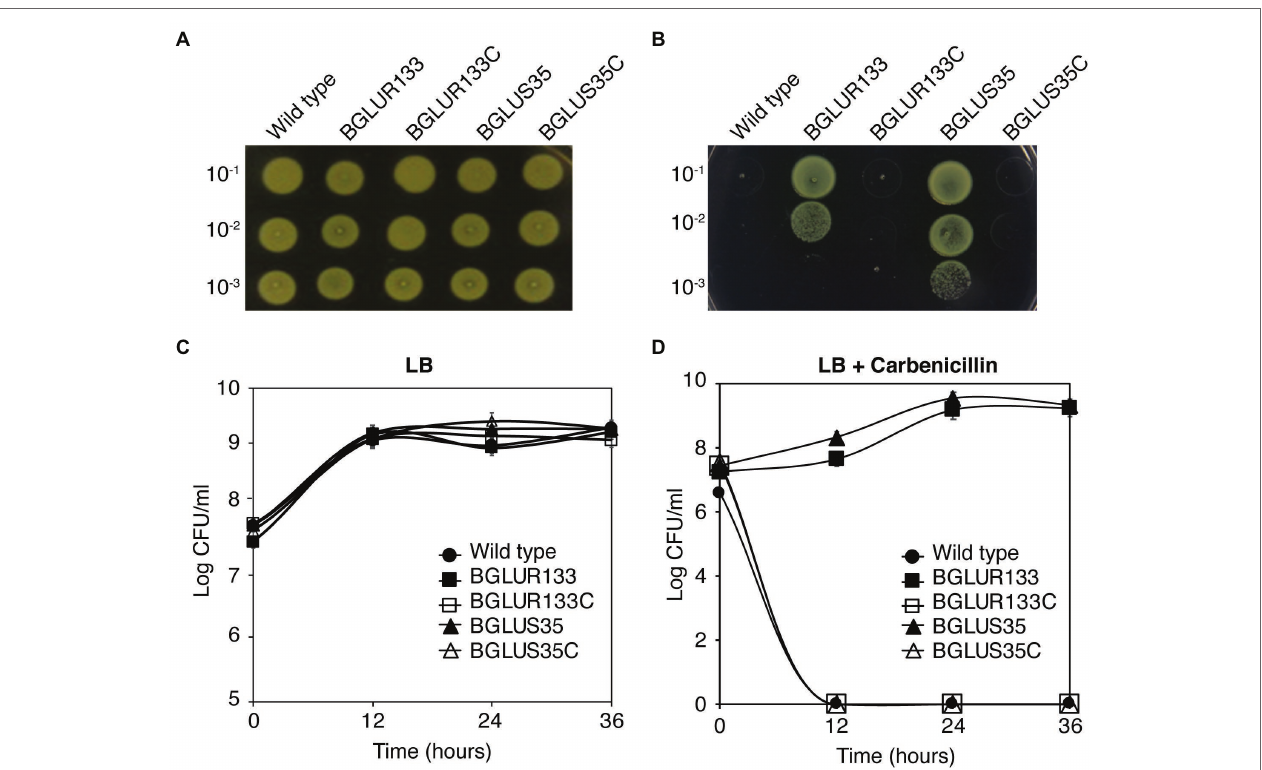
FIGURE 1 | Mutations in the GluS-GluR two-component system (TCS) induce β -lactam antibiotic resistance in Burkholderia glumae . (A,B) Bacteria strains of the wild-type (WT), gluS mutant (BGLUS35), gluR mutant (BGLUR133), and complemented mutant strains (BGLUS35C and BGLUR133C) grown on plain Luria Bertani (LB; A ) and LB medium with 50 μ g/ml carbenicillin (B) were serially diluted and spotted on LB agar. The plates were incubated for 2 days at 37 ° C and then photographed. (C,D) Cell population density was quantified in the indicated bacteria strains in (C) LB and (D) LB containing carbenicillin by counting colony-forming units (CFUs). The results are expressed as logarithmic values of CFU/ml. Error bars denote SE of experiments performed in